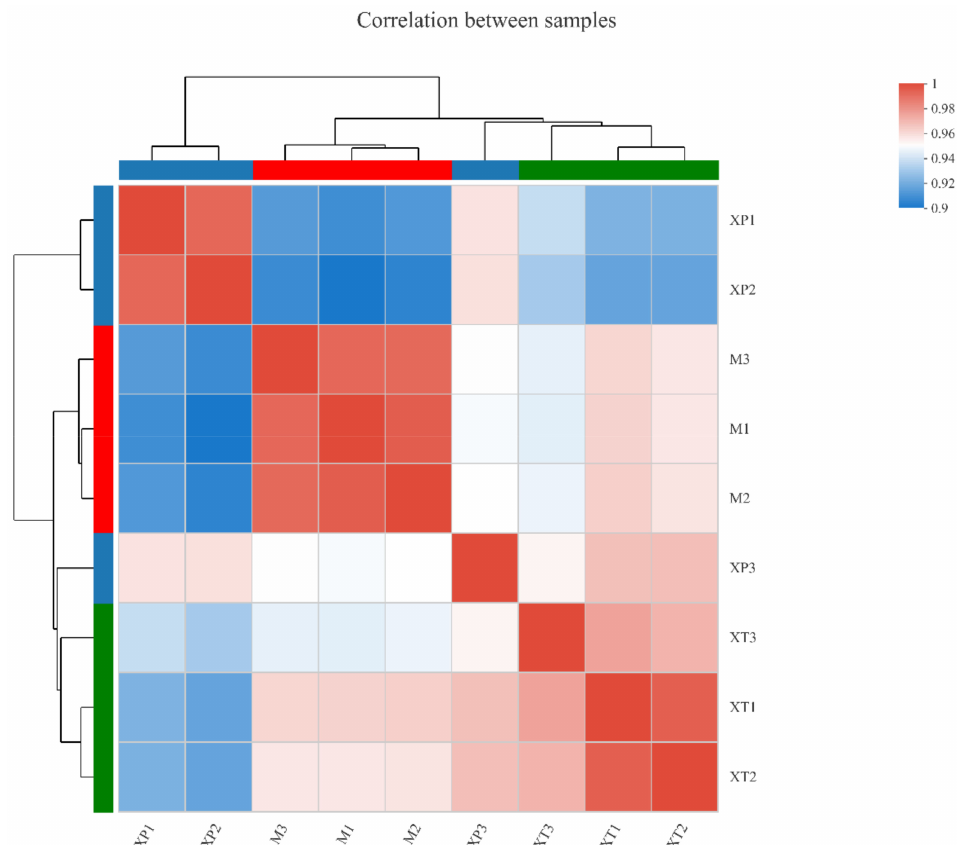
Figure 2. Correlation analysis between samples ( n = 3). The names of samples are located on the right and lower sides of the figure, sample clustering situations are located on the left and upper sides, and squares of different colors represent the correlation between the two samples. M: MRS group; XT; dpep group; XP: dpro